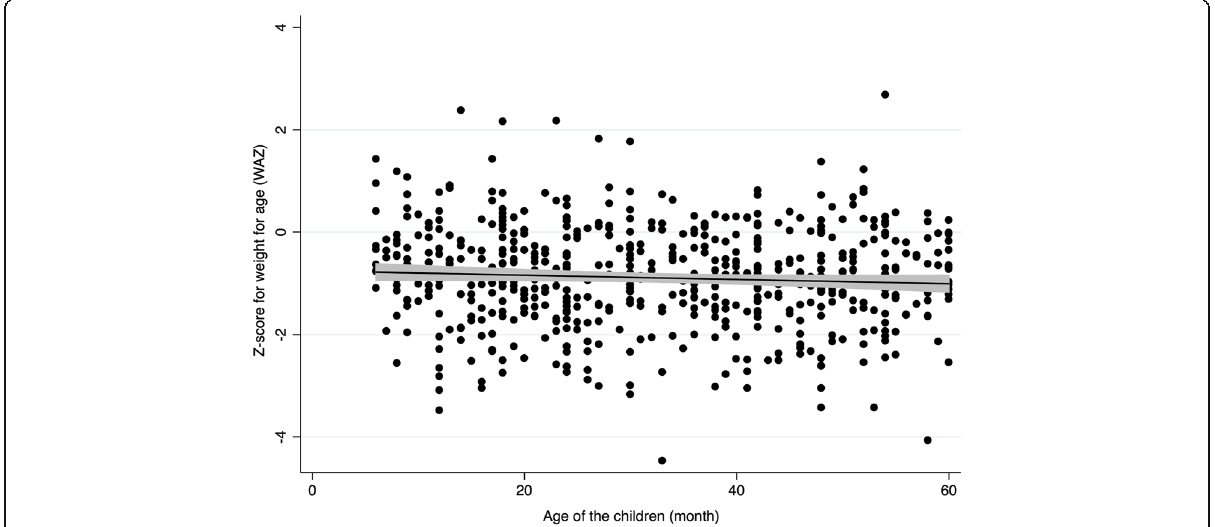
Fig. 2 Correlation of underweight (weight-for-age z -scores) with the age of the children in the first survey. This scatter diagram shows the distribution of z -scores of weight-for-age (WAZ) that is the measure of underweight, with the fitting line and shaded 95% confidence interval, of